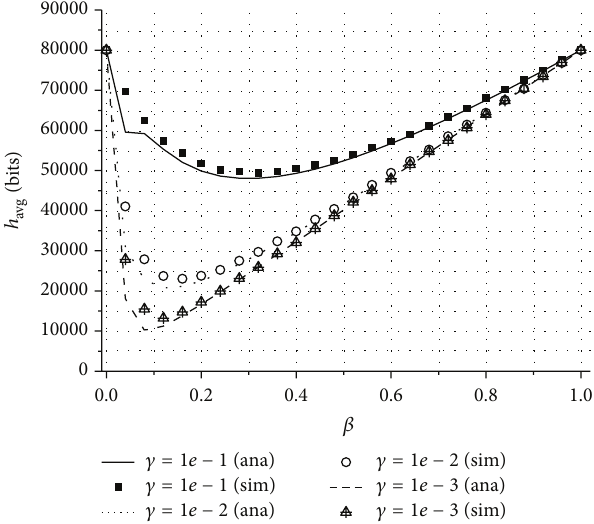
Figure 2: The average number of bits to be transmitted by each node ) for different 𝛽 and 𝛾 values. in the network ( ℎ avg